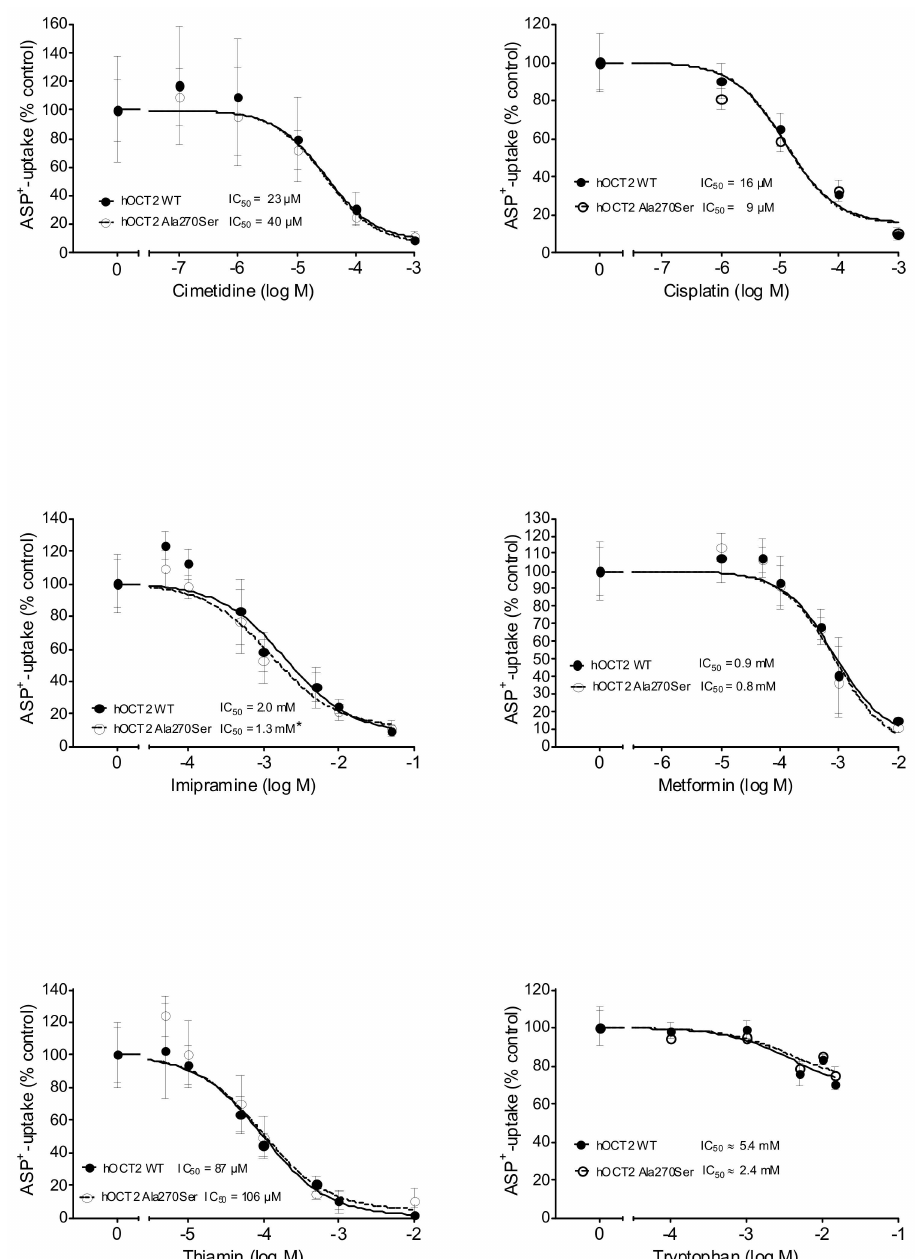
Figure 3. This figure shows the inhibition of ASP + uptake (mean ± SEM) by cimetidine (upper left panel, 12–60 replicates for each concentration), cisplatin (upper right panel, 6–18 replicates), imipramine (middle left panel, 18–72 replicates), metformin (middle right panel, 18–54 replicates), thiamin (lower left panel, 12–54 replicates), and tryptophan (lower right panel, 6–12 replicates) in hOCT2 WT ( (cid:8) , continued line) and hOCT2 Ala270Ser ( , dotted line) cells, measured in at least 3 independent experiments. (cid:35) For every substance except tryptophan, a concentration-dependent inhibition of ASP + uptake was observed. The calculated IC 50 values are also reported in the figures. The IC 50 of imipramine was significantly di ff erent between hOCT2 WT and hOCT2 Ala270Ser (*) when compared using the extra sum-of-squares F test (GraphPad Prism), with the mutated transporter showing a higher a ffi nity for the